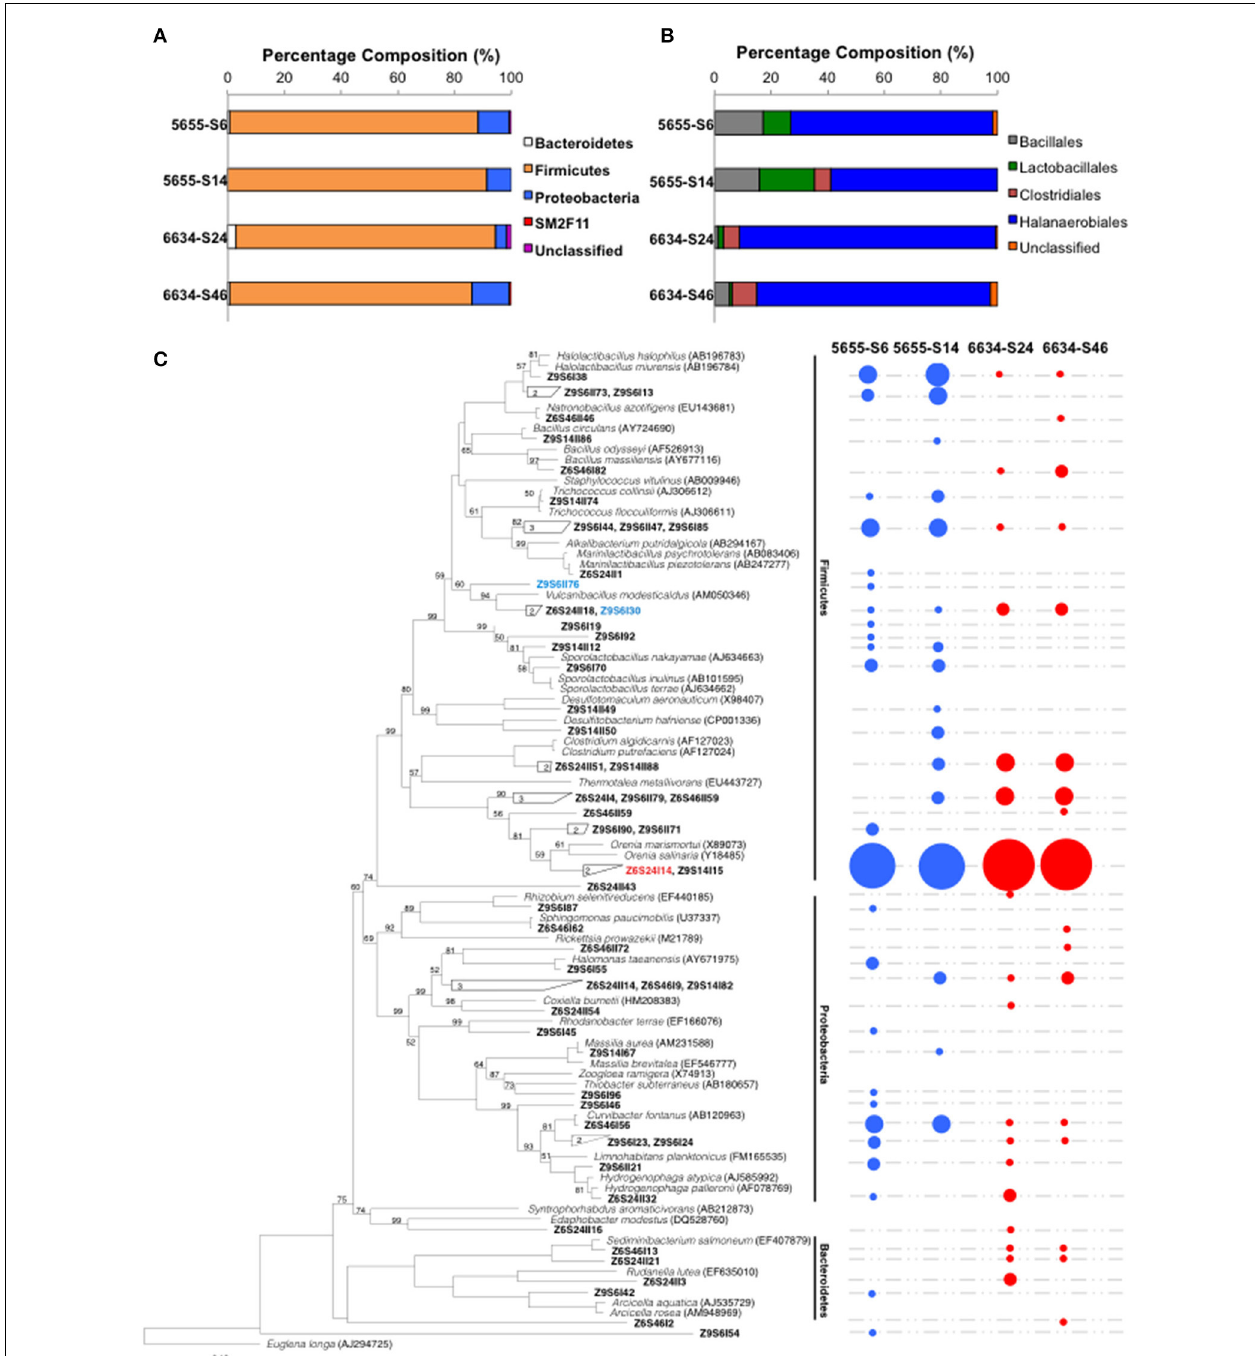
FIGURE 3 | Microbial composition (A), the dominant Firmicutes phylum (B) and phylogenetic tree (C) of the microbial communities inhabiting in the formation water collected from 1.72 to 2.02km in depth of the IBDP verification well VW1. The values n and n’ listed on the top of the figures (A,B) indicate number of 16S rRNA used for analyses. Both the intermediate and final samples are included in this analysis. The IDs in bold fond in (C) indicate the OTUs of the microbial communities identified using 97% as the cutoff value. The OTUs belonging to the same clusters were grouped together and the numbers of grouped OTUs were labeled in the clades. The circles on the right